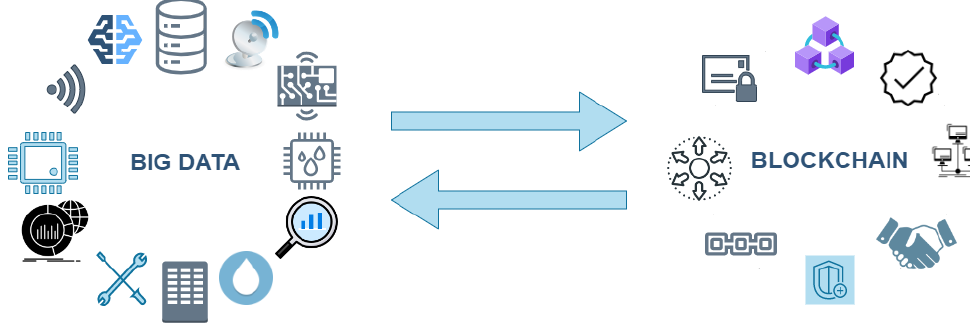
Figure 4. Big Data and Blockchain—Technology